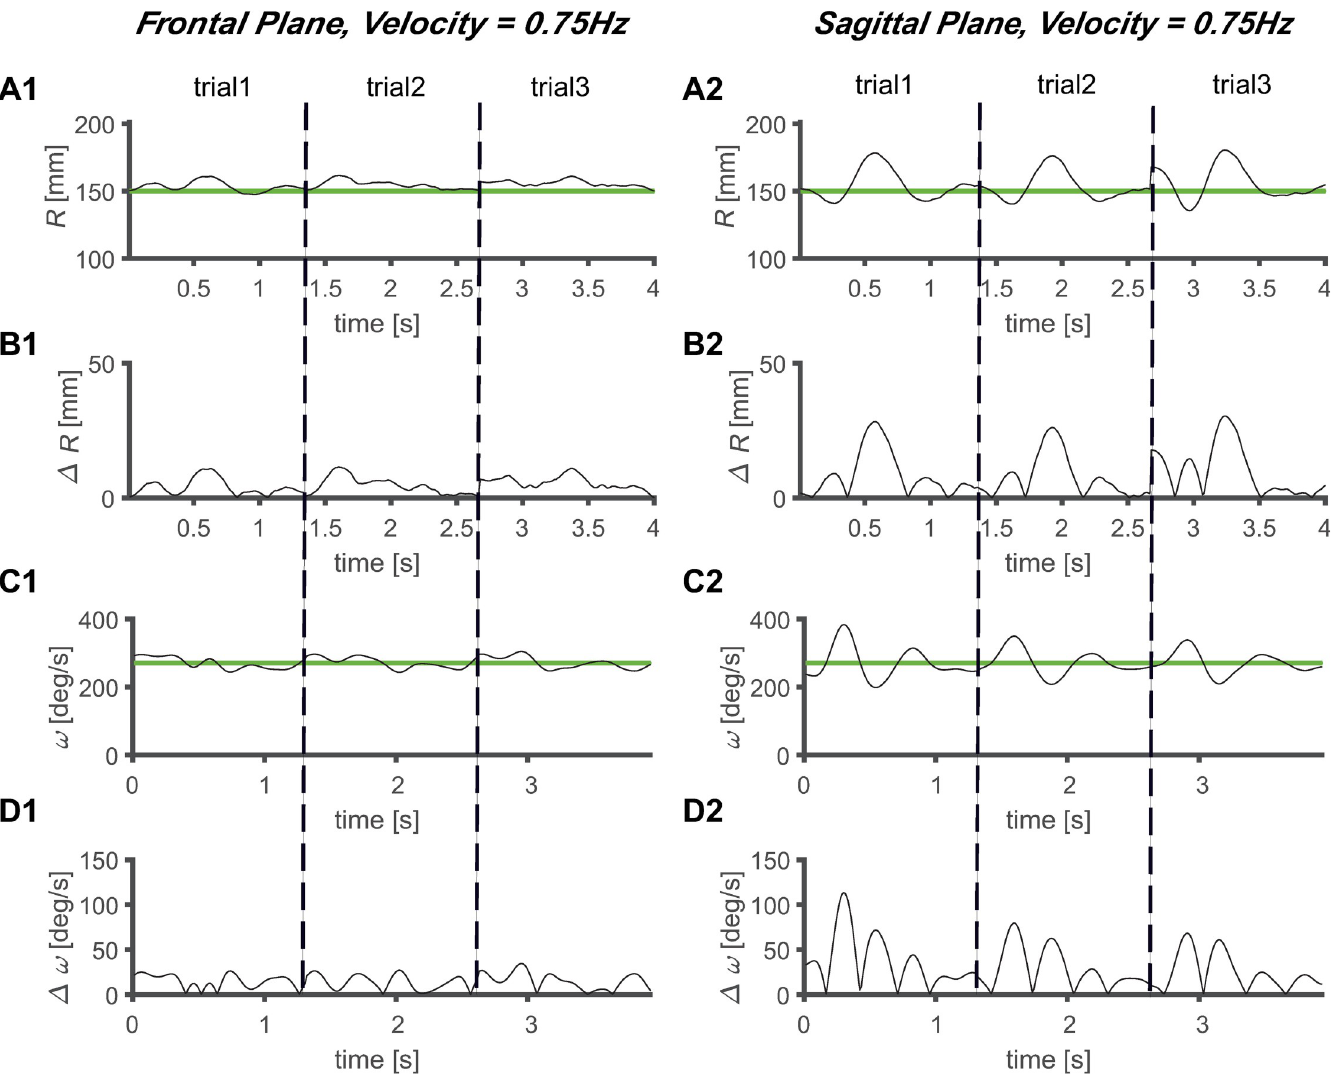
Fig 8. Average circular tracking movement at 0.75 Hz. R value for three trials on the (A1) frontal plane (A1) and (A2) sagittal plane. Absolute value of Δ R on the (B1) frontal plane (B1) and (B2) sagittal plane. ω value for three trials on the (C1) frontal plane (C1) and (C2) sagittal plane. Absolute value of Δ ω on the (D1) frontal plane (D1) and (D2) sagittal